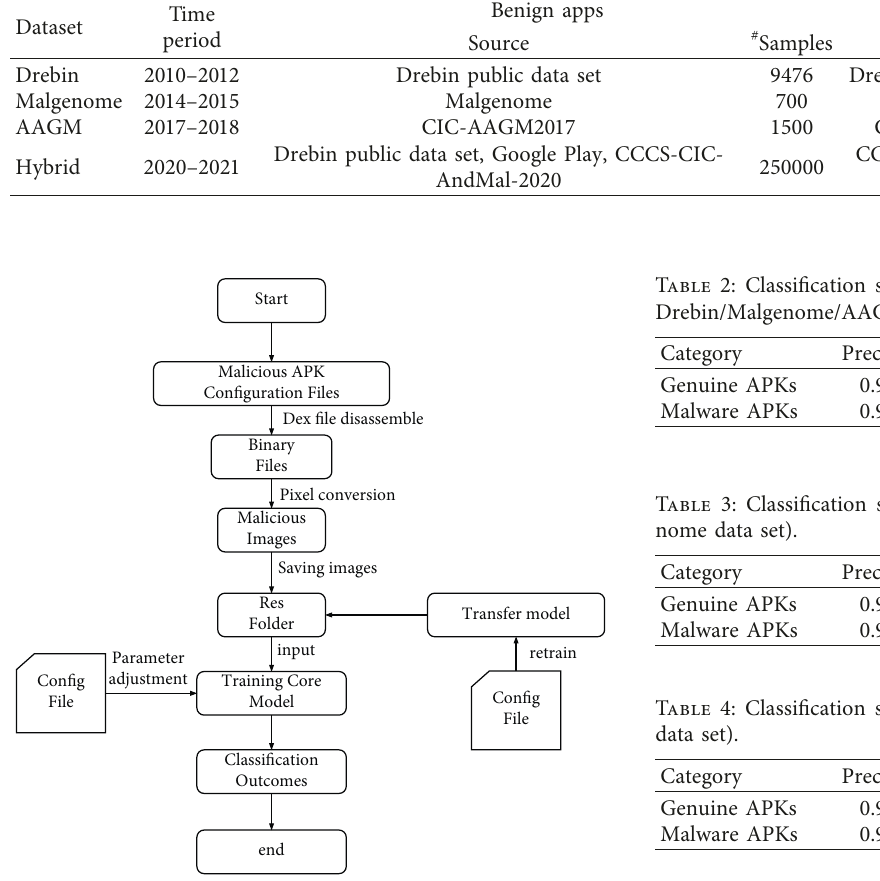
Figure 10: Experimental flowchart.